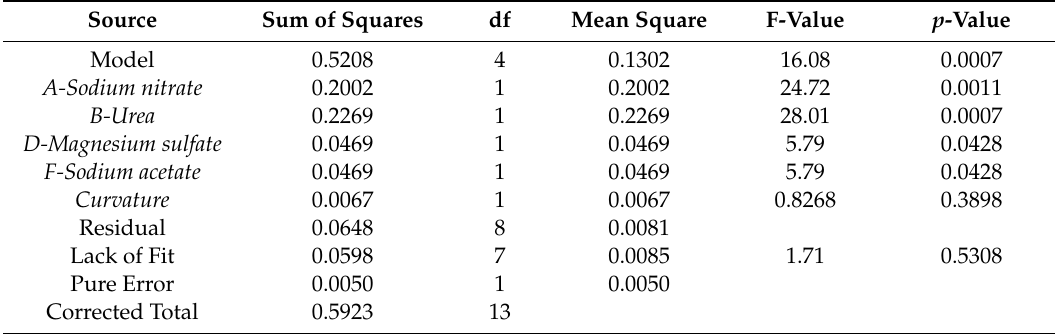
Table 2. ANOVA of the reduced model from Plackett–Burman design (PBD) screening for C. vulgaris biomass density.